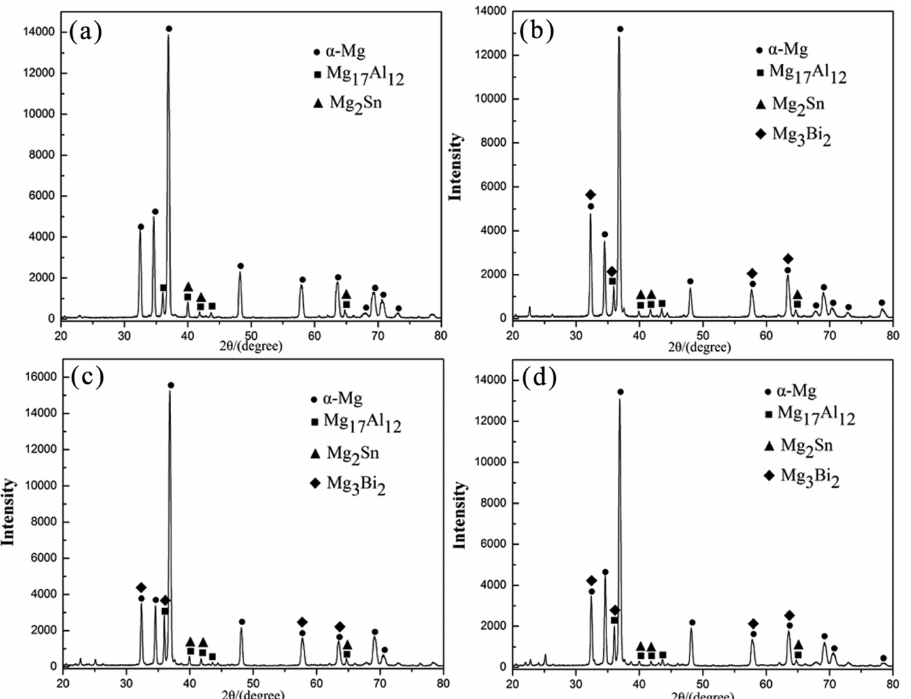
Figure 1: The XRD patterns of the as-cast AZ80 – 2Sn alloys with different Bi additions: (a) 0 mass %Bi; (b) 0.5 mass %Bi; (c) 1 mass %Bi; (d) 1.5 mass %Bi.